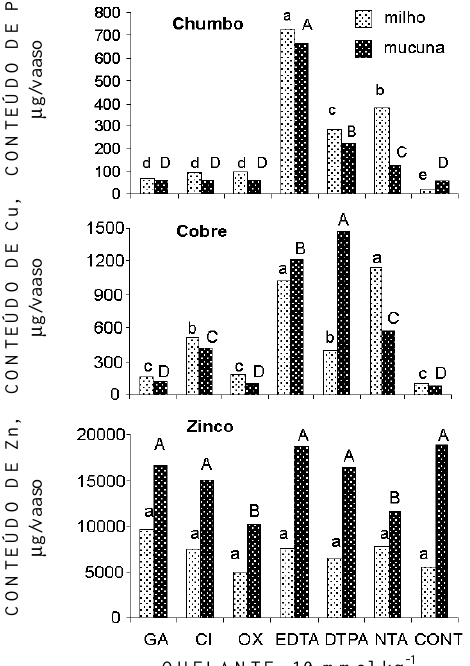
Figura 2. Remoção de Pb, Cu e Zn pela parte aérea do milho e da mucuna em solo tratado com 10 mmol kg -1 de quelantes. As letras minúscu- las comparam os tratamentos no milho e as mai- úsculas, os tratamentos na mucuna preta. Le- tras iguais não diferem estatisticamente (Teste Scott-Knott, P < 0,05). GA = Ácido gálico; CI = Ácido cítrico; OX = Ácido oxálico; CONT = Con-